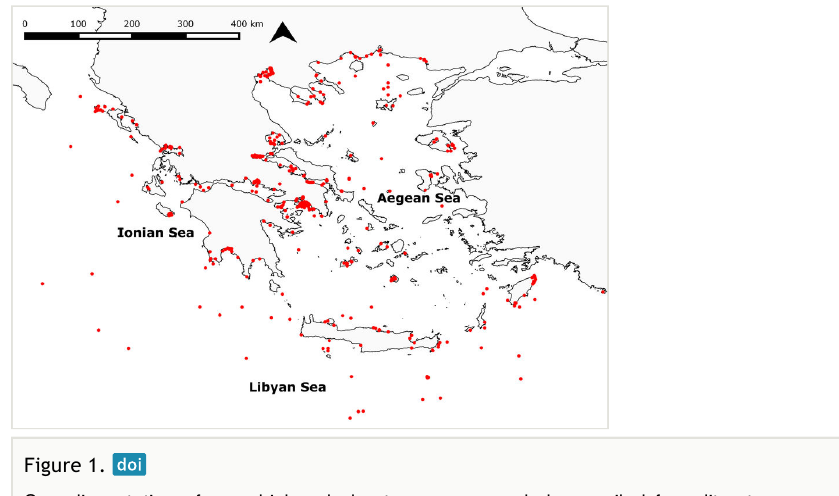
and databases which where not included in previous